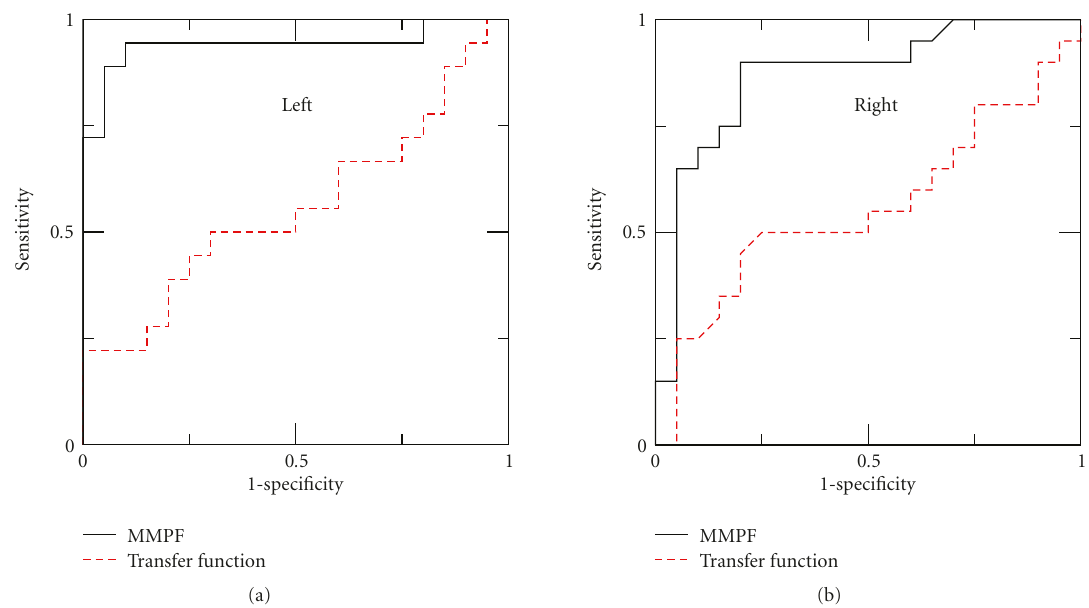
Figure 7: Receiver operating characteristic (ROC) curves for the DM prediction using BP-BFV phase shifts obtained from the MMPF method and using transfer function phases (0.1–0.4Hz) (adapted from [16]). The y -axis is the sensitivity, representing the percentage of DM subjects identified; and the x -axis is 1-specificity; that is, the percentage of control subjects that are incorrectly identified as DM subjects. The areas under the ROC curves (AUC) closer to 1.0 for BP-BFV phase shifts indicates that the MMPF measure serve as a better discriminator between the control and DM groups than traditional transfer function